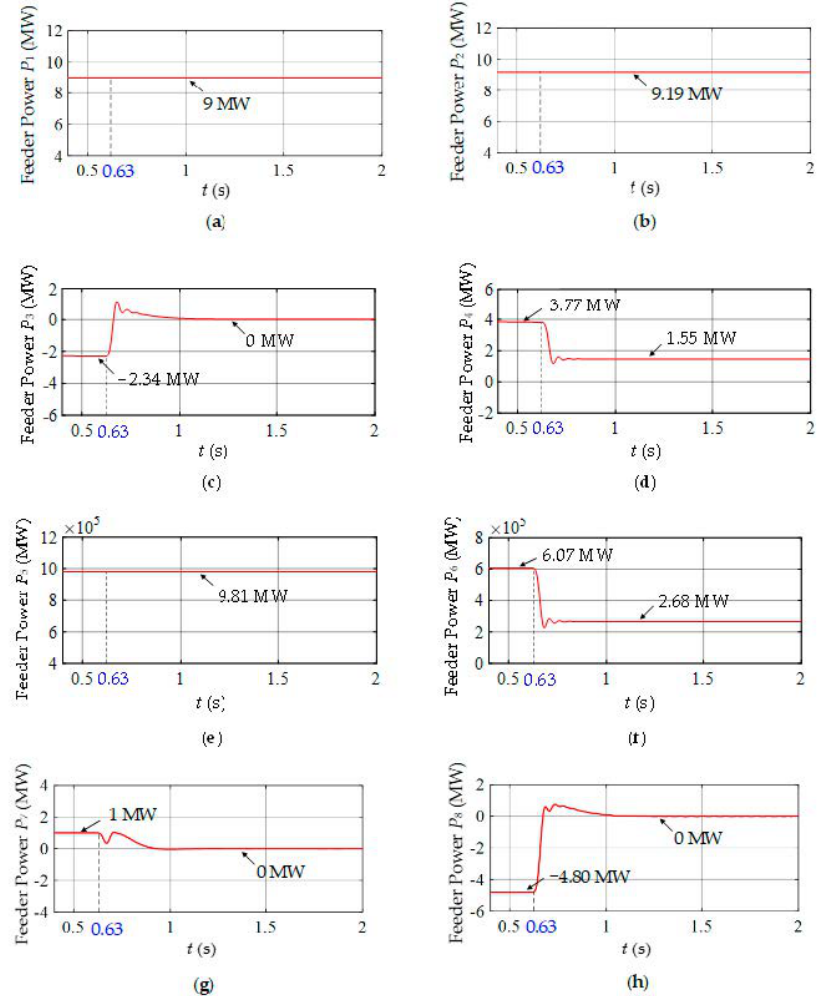
Figure 14. Feeder power waveforms of the eight power supply sectors before and after EMS optimal regulation: ( a ) S 1 ; ( b ) S 2 ; ( c ) S 3 ; ( d ) S 4 ; ( e ) S 5 ; ( f ) S 6 ; ( g ) S 7 and ( h ) S 8